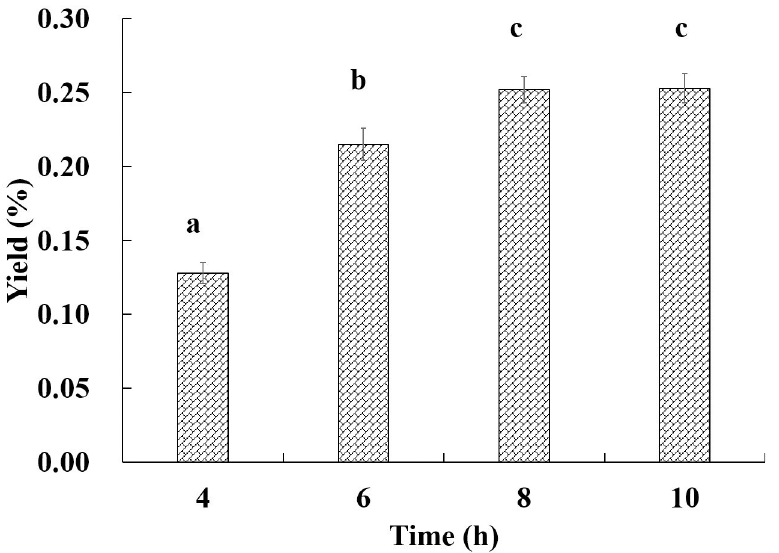
Fig 2. The effect of distillation time on the isolation of essential